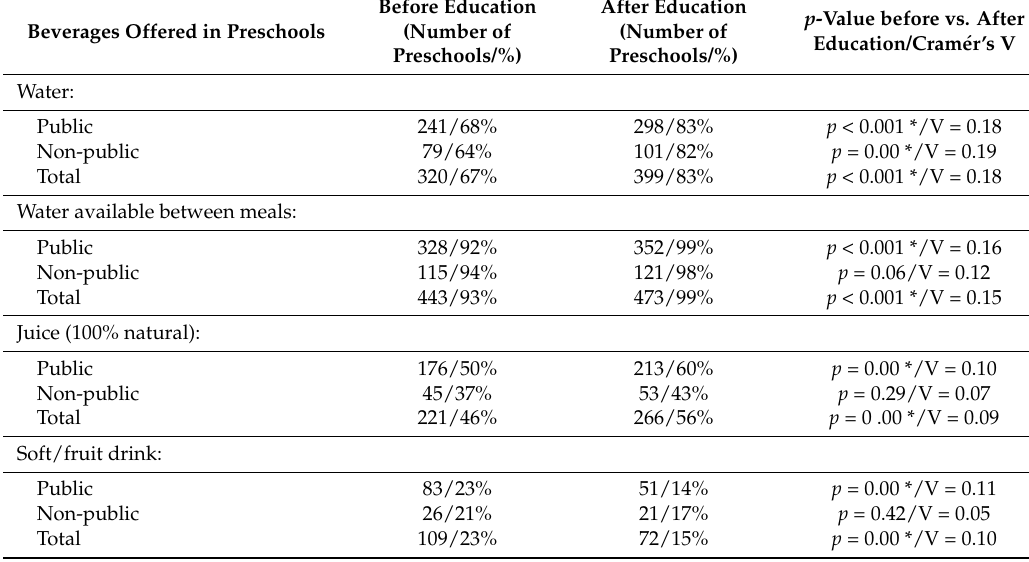
Table 2. Assortment of beverages offered to children in preschools before and 3 months after education: public ( n = 355), non-public ( n = 123), and data for the total group ( n = 478).